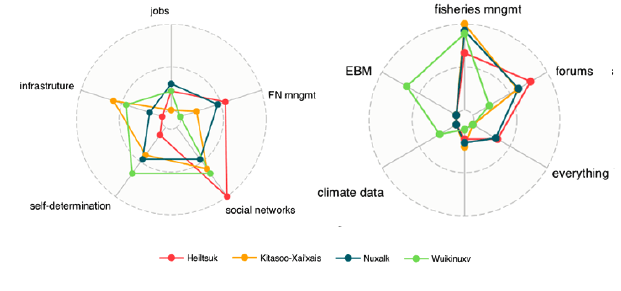
we also need to prepare for the worst because I think it will come at some point.” Fig. 2 . Radar plots describing the different primary social (left) and ecological (right) adaptation actions identified by participants in the four First Nations (Heiltsuk, Kitasoo/ Xai’xais, Nuxalk, Wuikinuxv). Adaptation strategies are the same as those listed in Table 4. FN: First Nation; EBM: ecosystem-based management; MPAs: marine protected